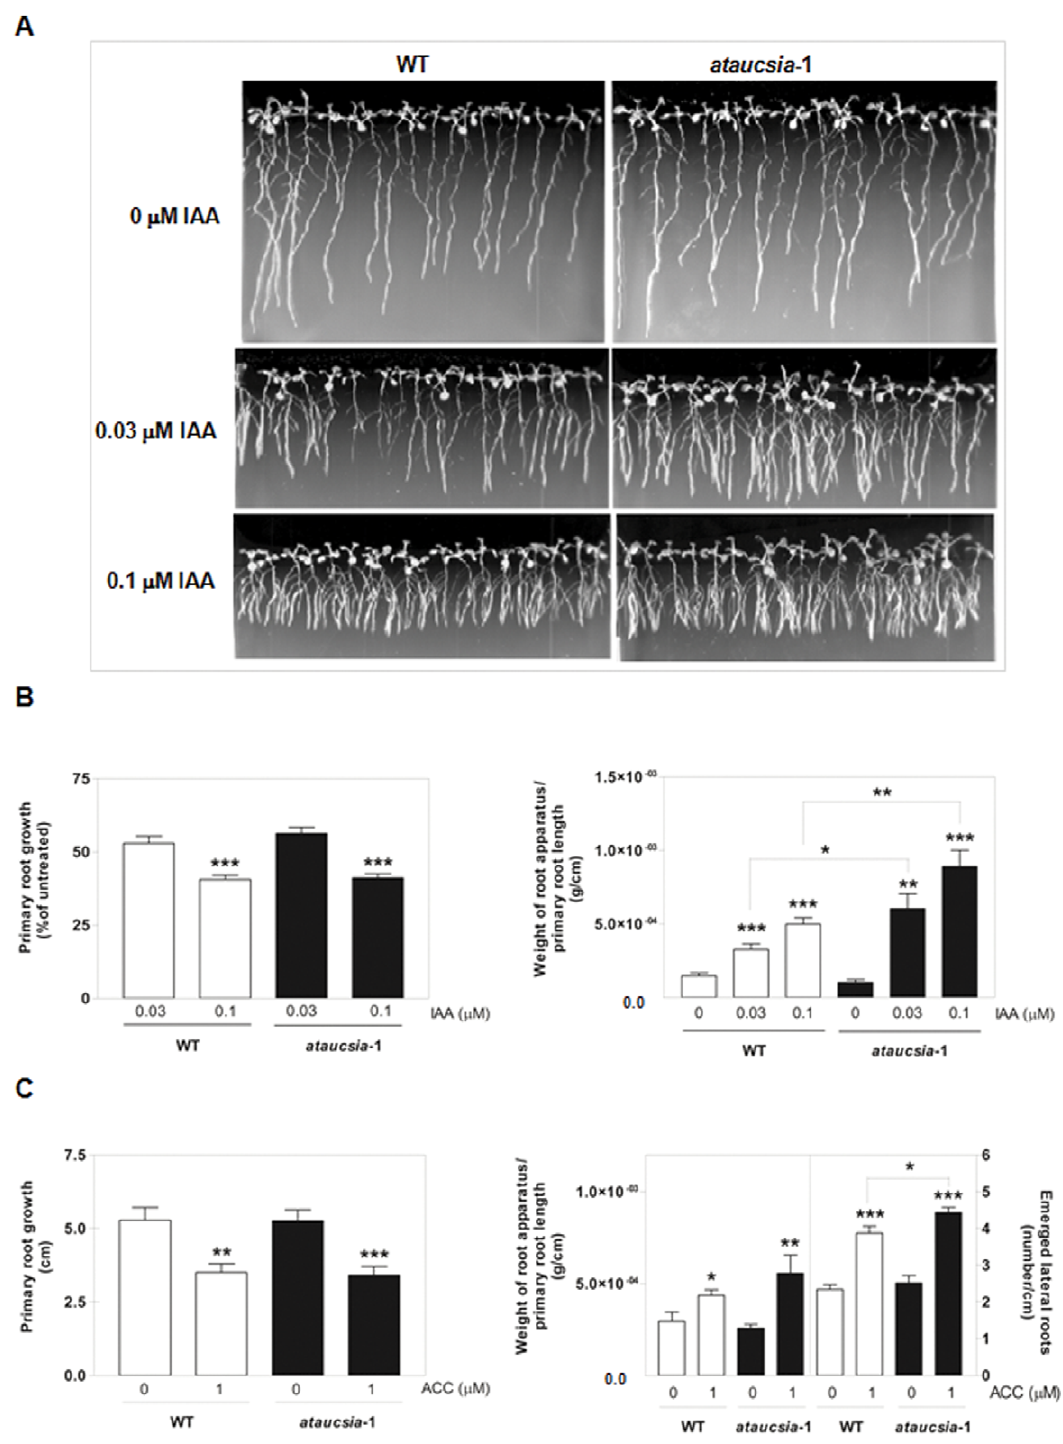
Figure 4. Effects of exogenous IAA and ACC on ataucsia -1 root growth. (A) Root phenotype of 10 days old wild-type and ataucsia -1 seedlings after treatment with IAA (0.03 and 0.1 m M). (B) Quantification of IAA effect on root growth. Seeds of wild-type and ataucsia -1 were germinated on nutrient medium for 5 days and then transferred to new medium either supplemented or not supplemented with IAA (0, 0.03 and 0.1 m M). Five days later, new root growth was evaluated. (Left) New primary root growth was measured and plotted as percentage of root growth on medium without IAA. (Right) Weight of root apparatus per cm of primary root length. (C) Quantification of ACC effect on root growth. As performed for panel B, 5 days old seedlings were transferred to medium supplemented or not with ACC (0, and 1 m M). Five days later, root growth was evaluated. (Left) Primary root growth. (Right) Two sets of y-axes are reported, on the left y-axis the weight of root apparatus per cm of primary root length and on the right y- axis the density of emerged lateral roots (number of lateral roots per cm of primary root). The values reported in B and C are means 6 SE (n=3) 15–20 seedlings per replicate. Student’s t -test was applied. *P , 0.05; **P , 0.01; ***P , 0.001 versus untreated seedlings or versus treated wild-type seedlings when indicated by brackets. doi:10.1371/journal.pone.0041327.g004 PLoS ONE |